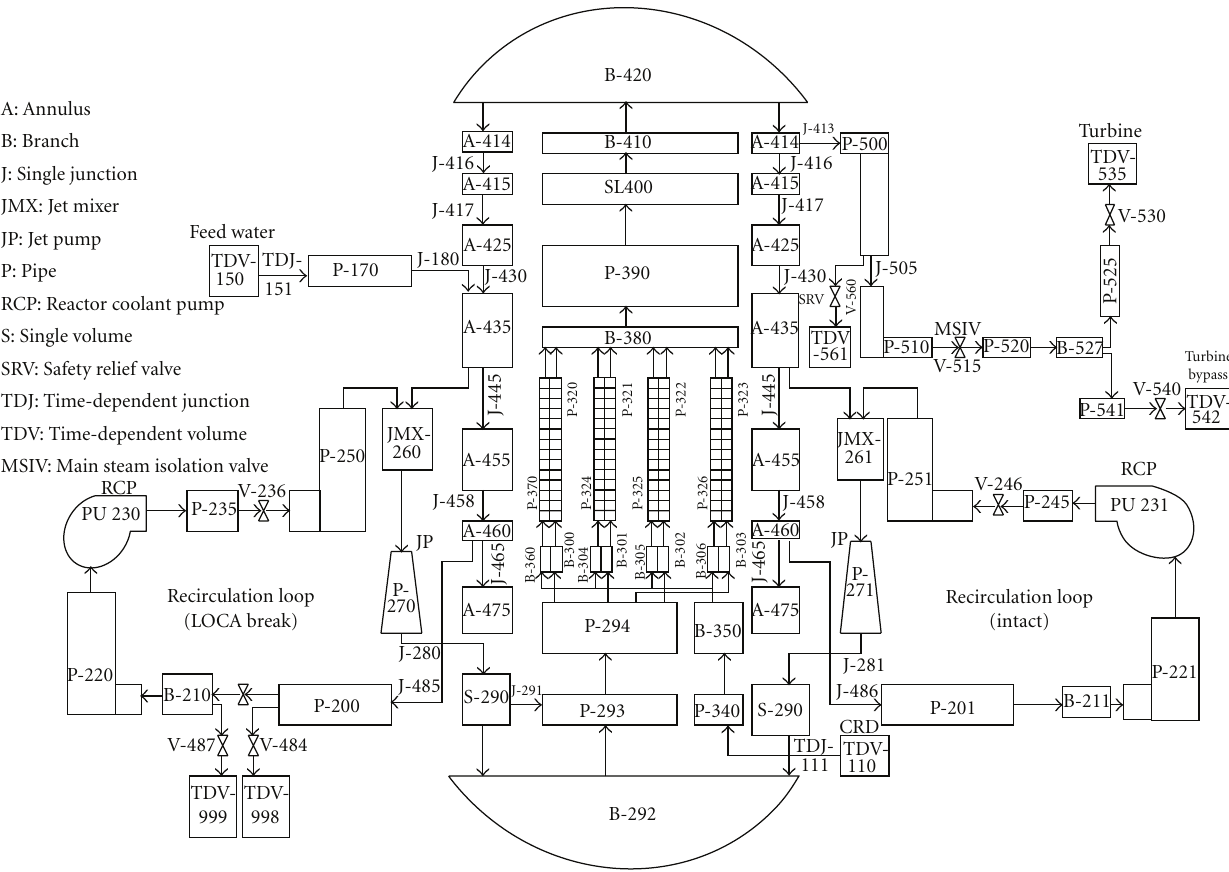
Figure 5: Overall Laguna Verde RELAP/SCDAPSIM thermal hydraulic component